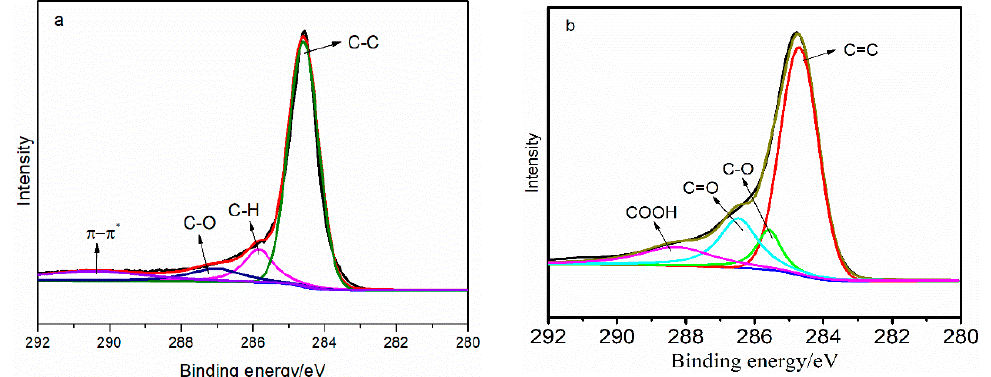
Figure 3. X-ray photoelectron spectroscopy (XPS) tests on high-resolution scans of C 1 s spectra of ( a ) GE and ( b ) TPG.